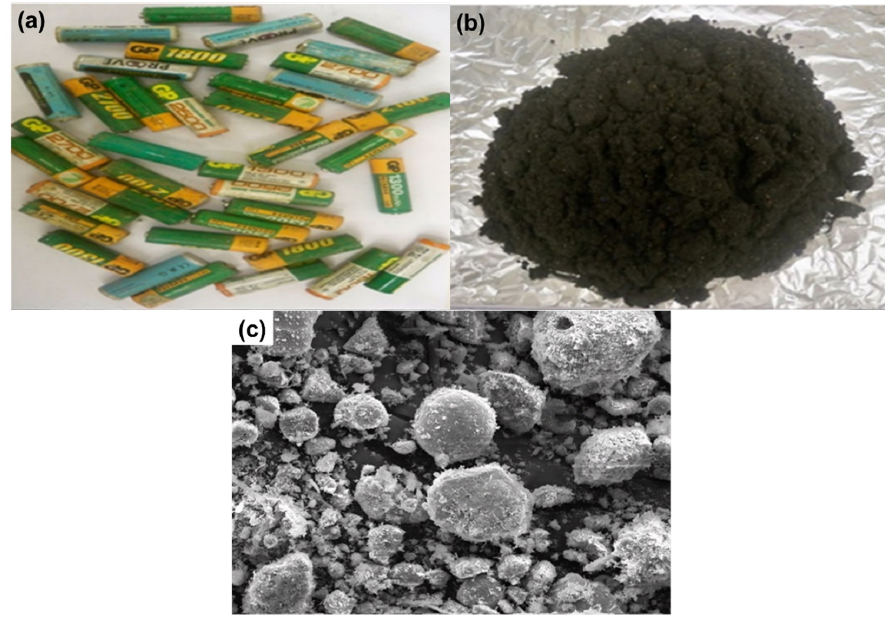
Figure 1. ( a ) Spent nickel–metal hydride (Ni ‒ MH) batteries; ( b ) Black powder of Ni ‒ MH batteries; ( c ) SEM of the obtained black powder of Ni ‒ MH batteries. ( c ) SEM of the obtained black powder of Ni–MH